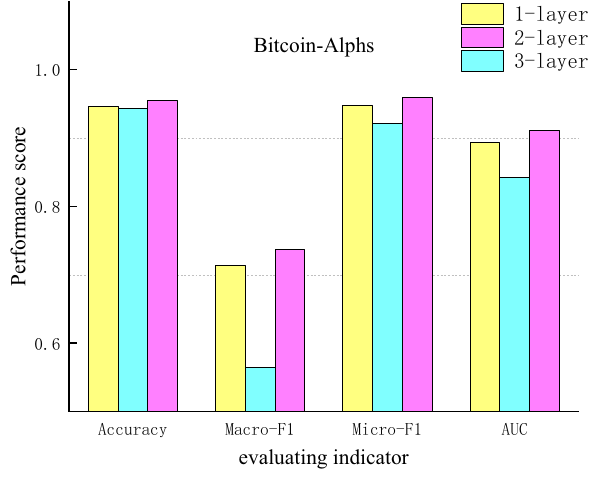
Fig. 7 The effect of stacking multiple layers